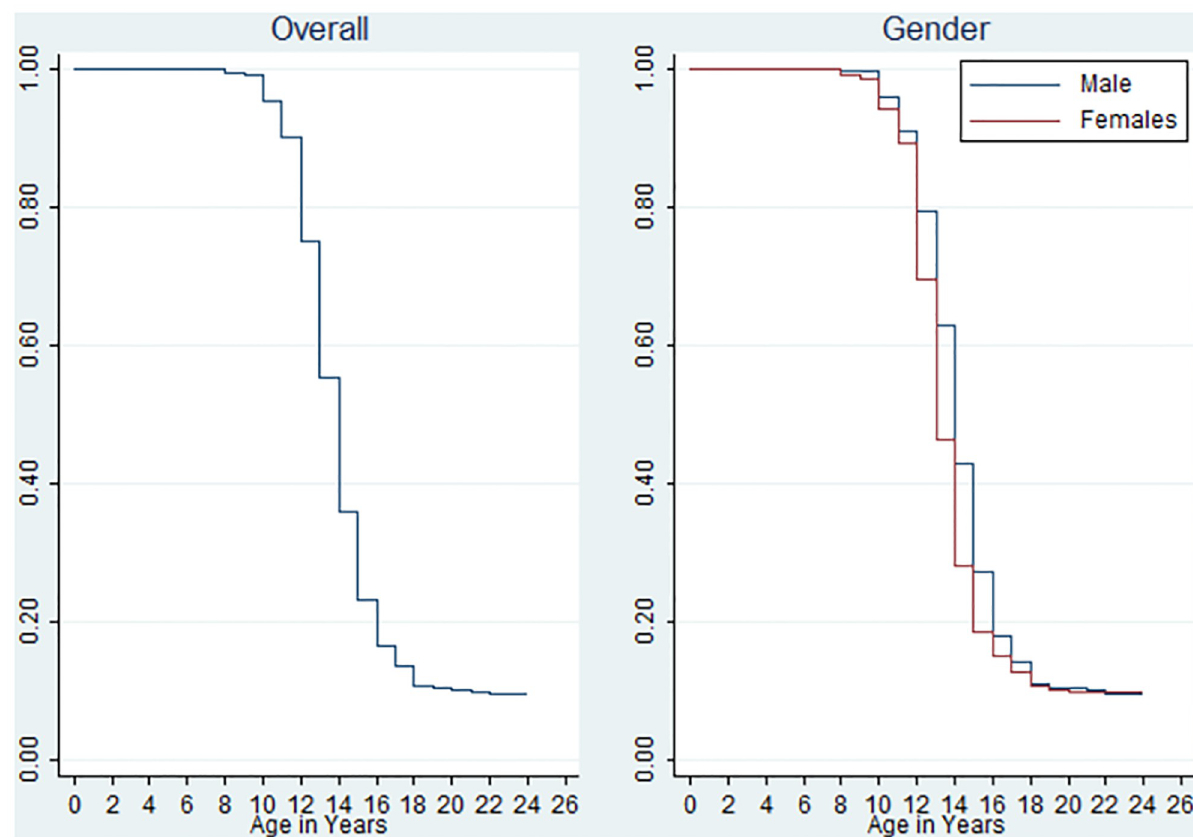
Fig 1. Survivorship curves showing probabilities of developing pubic hair at different ages by sex.